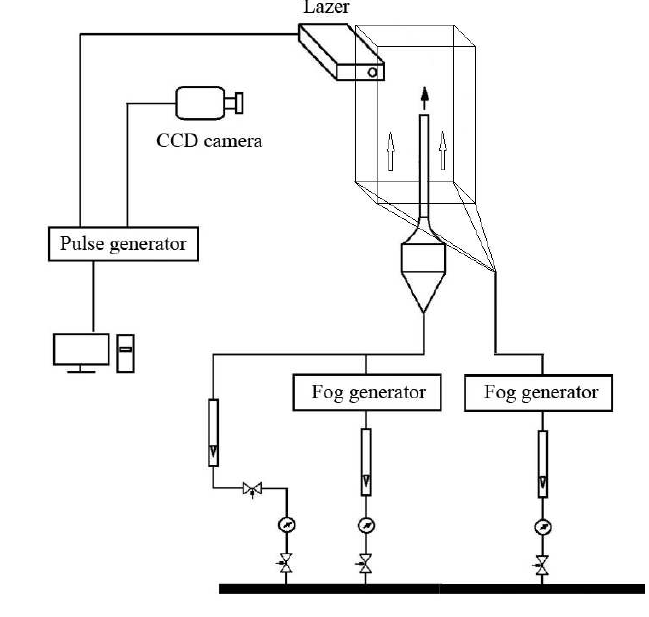
Fig. 1. Experimental